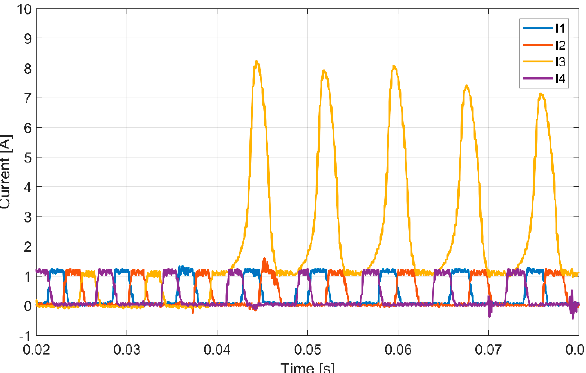
Figure 22. Motor winding currents of the SRM at 600 rpm in normal operation and short-circuit failure of power device S 1 C (experimental result).